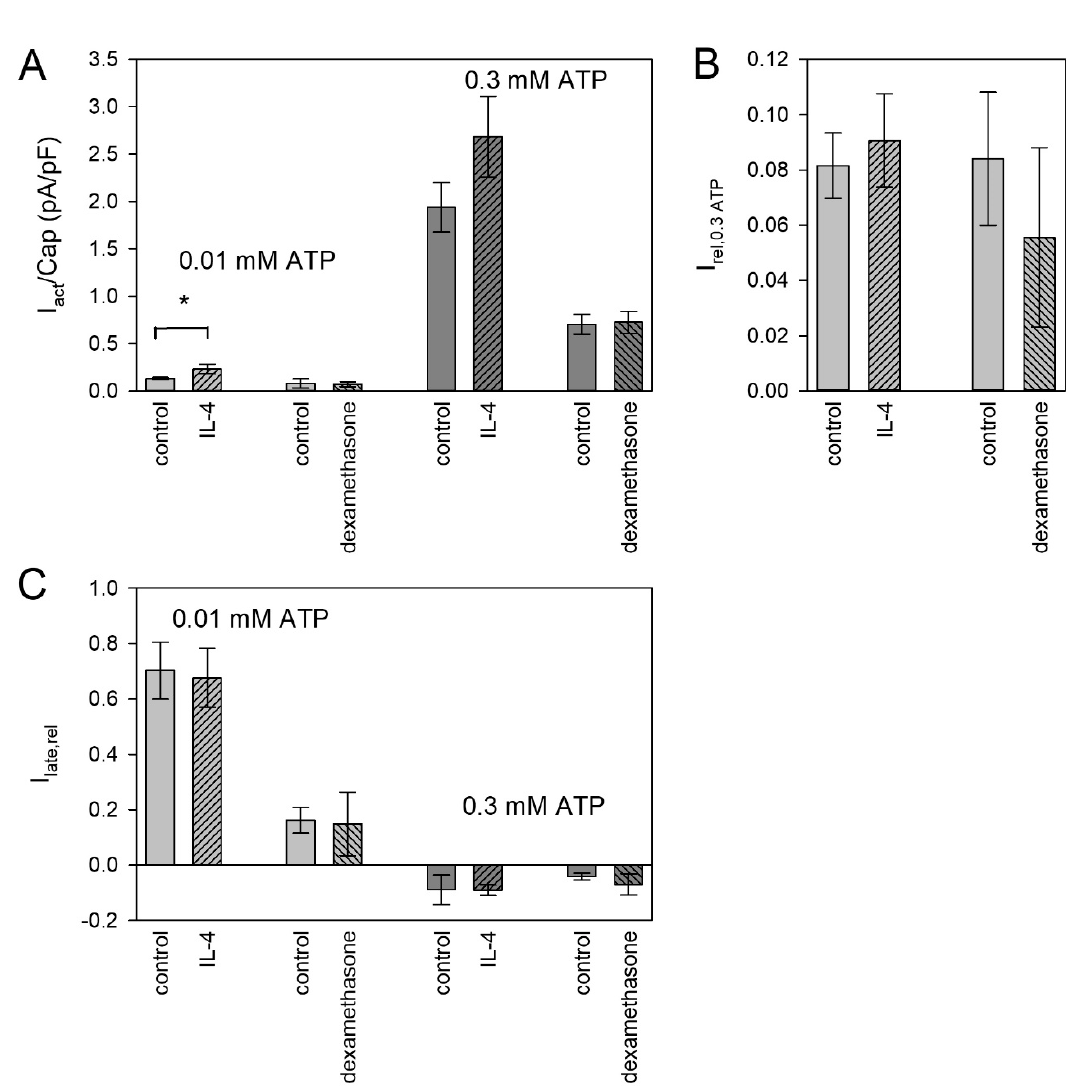
Figure 7. Effect of anti-inflammatory mediators on ATP-induced currents. Shown are ( A ) current densities, ( B ) relative currents and ( C ) relative current amplitudes of the late current I late,rel . For further details, see Figure 6. Means ± SEM of 8–16 cells. Significant differences from the control are marked by asterisks.